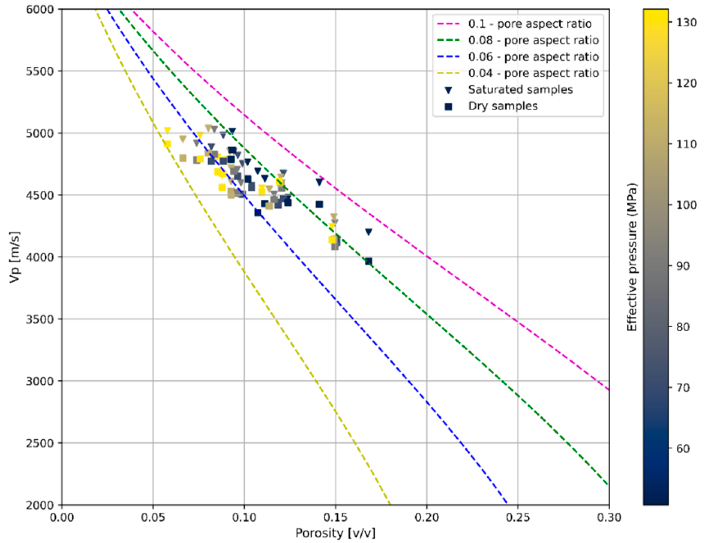
Figure 7. P-wave velocity and porosity crossplot with defined Kuster and Toksöz model. Penny shaped pores are assumed. Data are colored according to the value of effective pressure. Input elastic parameters are calcite: K = 76.8 GPa, µ = 32 Gpa; water K = 2.1 Gpa.